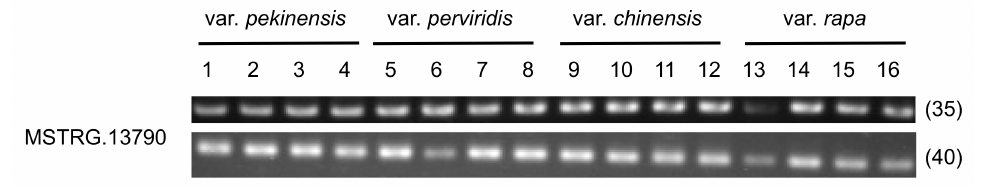
Figure 7. The average number of SNPs per length (base pair) in region coding lncRNAs of RJKB-T23 and RJKB-T24. The values with the same letter are not significantly different with p < 0.001 by Tukey’s HSD test. Values are means ± standard error (s.e.) of SNP number per base pair. Next, to examine the transcriptional conservation of NATs, we tested whether six NATs were expressed in 14-day leaves of sixteen B. rapa lines comprising four varieties. All six NATs were expressed in all sixteen lines of B. rapa , though there was a small variation of expression levels among lines (Figure 8).